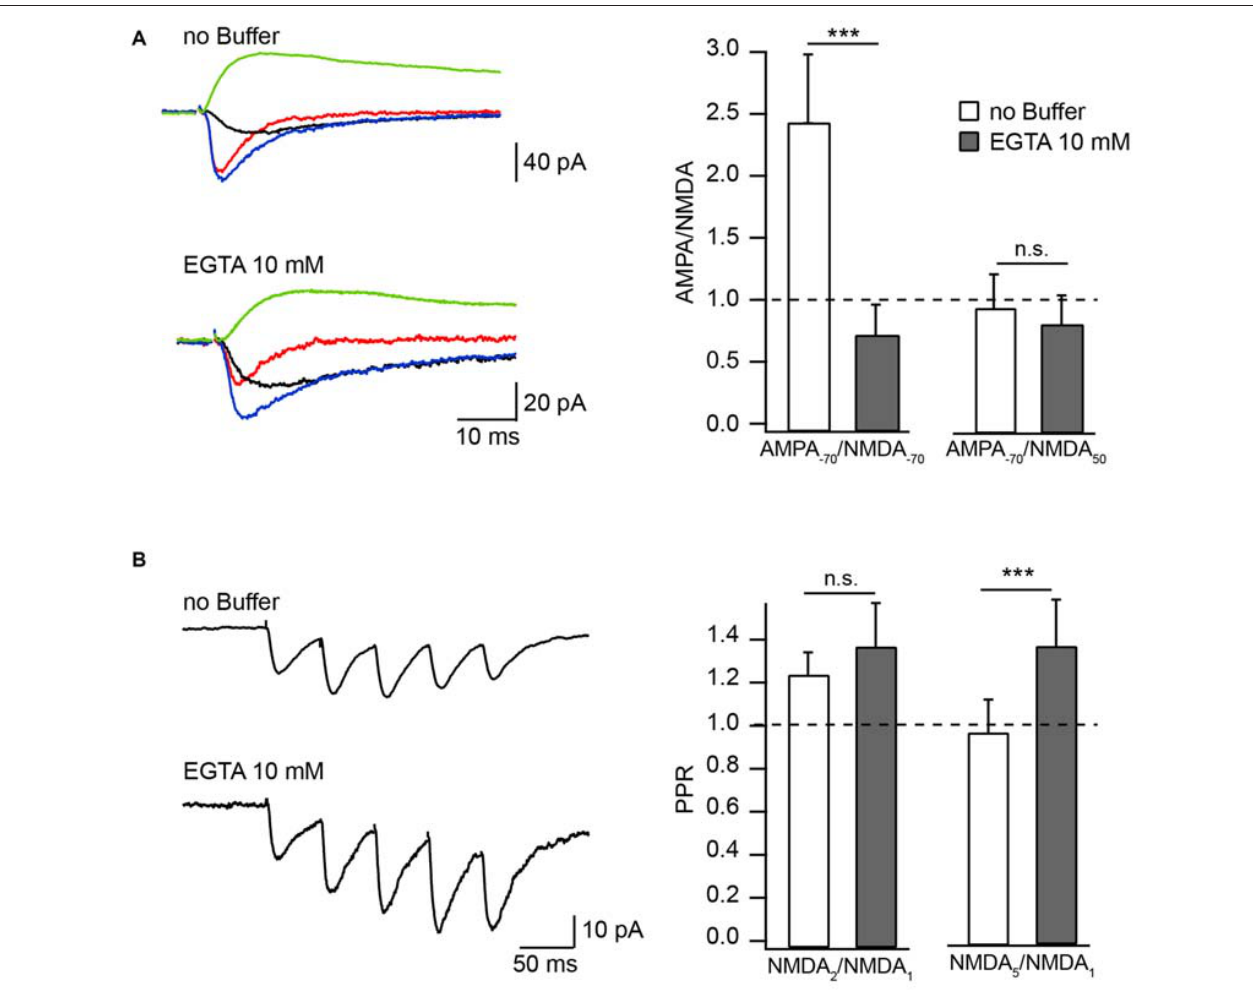
FIGURE 1 | Effect of Ca 2 + buffers on the amplitude of NMDAR mediated EPSC in Mg 2 + -free extracellular solution. (A) Averaged evoked compound EPSC (blue), aEPSC (red), nEPSC (black) at − 70 mV and nEPSC (green) at 50 mV recorded with buffer-free and EGTA-containing intracellular solutions. Bar histograms compare the effect of buffer loading on amplitude ratios of aEPSCs measured at − 70 mV to nEPSCs measured at − 70 mV (left) and 50 mV (right). (B) Averaged trains of NMDAR mediated EPSCs recorded with EGTA-free and EGTA-containing solutions. Bar histograms show the effect of EGTA loading on amplitude ratios (PPR) of the second (left) and the fifth (right) nEPSCs to the amplitude of the first response. Asterisks indicate significant